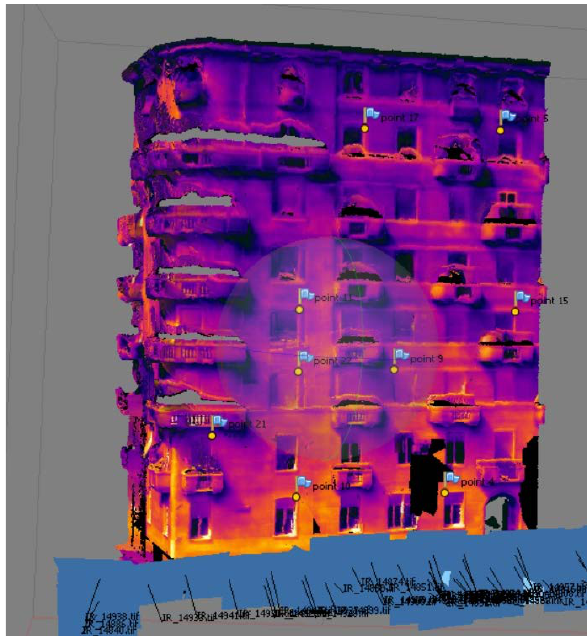
Figure 10 – Print-screen displaying the result of photogrammetric processing of IR images in Case Study 2: the TIN model of the building façade textured with IR images, the location of extracted GCP’s for co-registration to RGB data set, and estimated IR camera